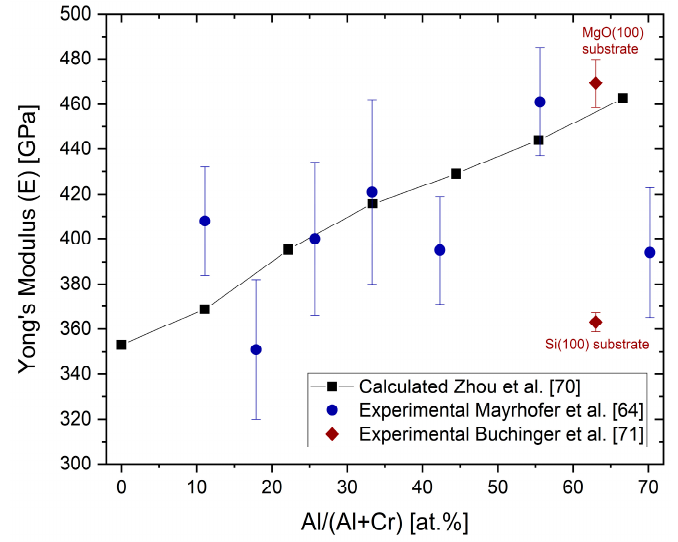
Figure 9. Ab initio calculated Young’s moduli E and experimentally obtained indentation moduli (black symbols) for different Al concentrations in fcc-(Cr,Al)N and fcc-(Al,Cr)N coatings, redrawn after [70], original © AIP Publishing, data from